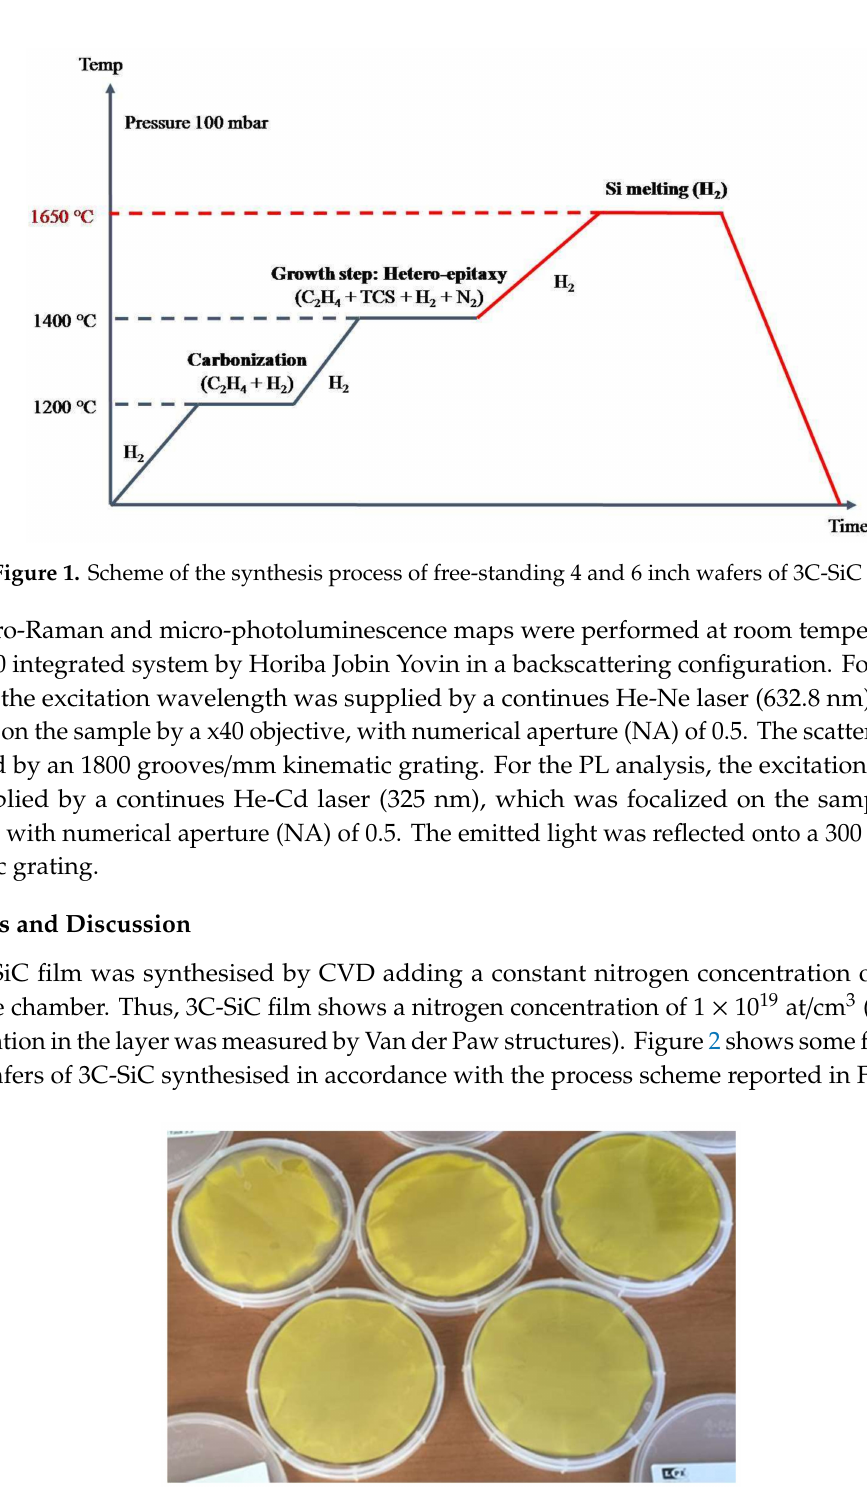
Figure 2. Free-standing 4 inch wafers of 3C-SiC. The growth was performed in a horizontal hot-wall chemical vapour deposition (CVD) reactor supplied by